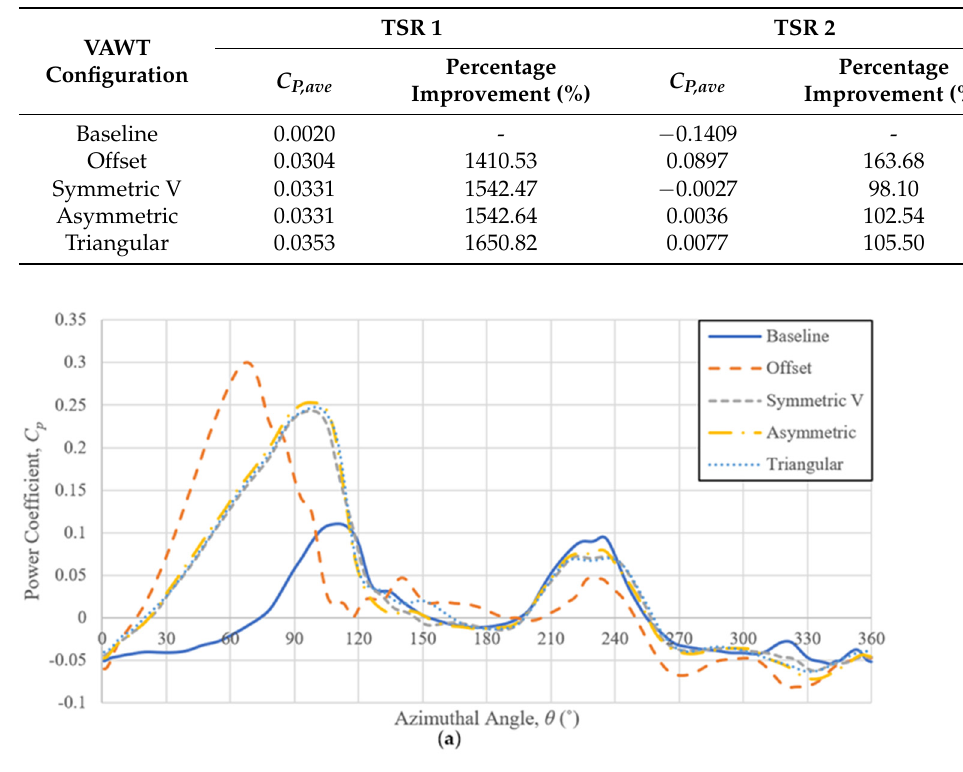
Figure 12. Comparison of C P at 0.015625H of Blade 1 in ( a ) TSR 1 and ( b ) TSR 2.